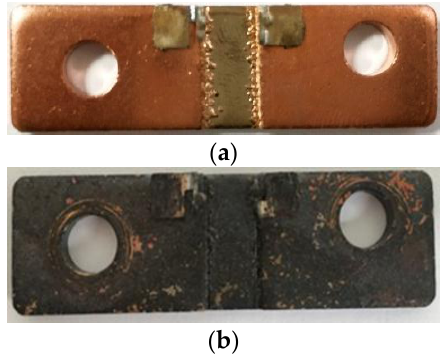
Figure 11. Images of shunt resistor ( a ) before and ( b ) after the high temperature stability test.